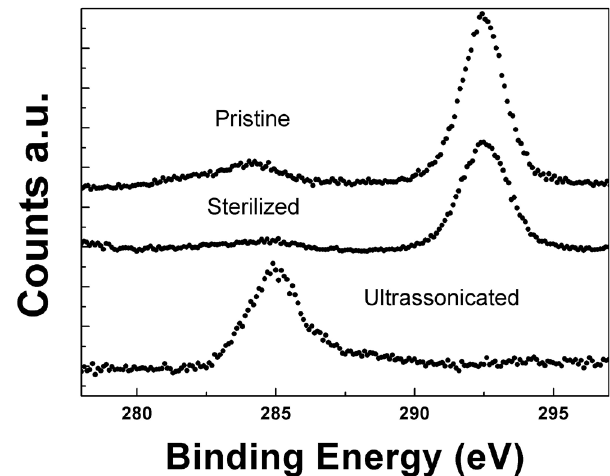
Fig. 4 – XPS spectra of samples from guide wire catheter type A.: pristine – A1, sterilized in ethylene oxide – AS1 and ultrasonically cleaned in enzymatic detergent – AU1. Suppression of CF peak related to CF bonds is observed in sample submitted to the ultrasound